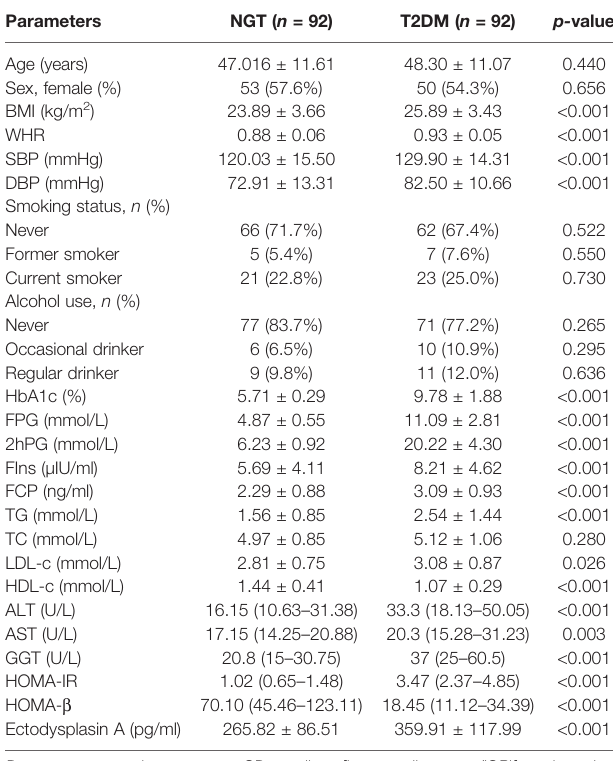
TABLE 1 | Clinical and biochemical characteristics in control subjects and in patients with T2DM.